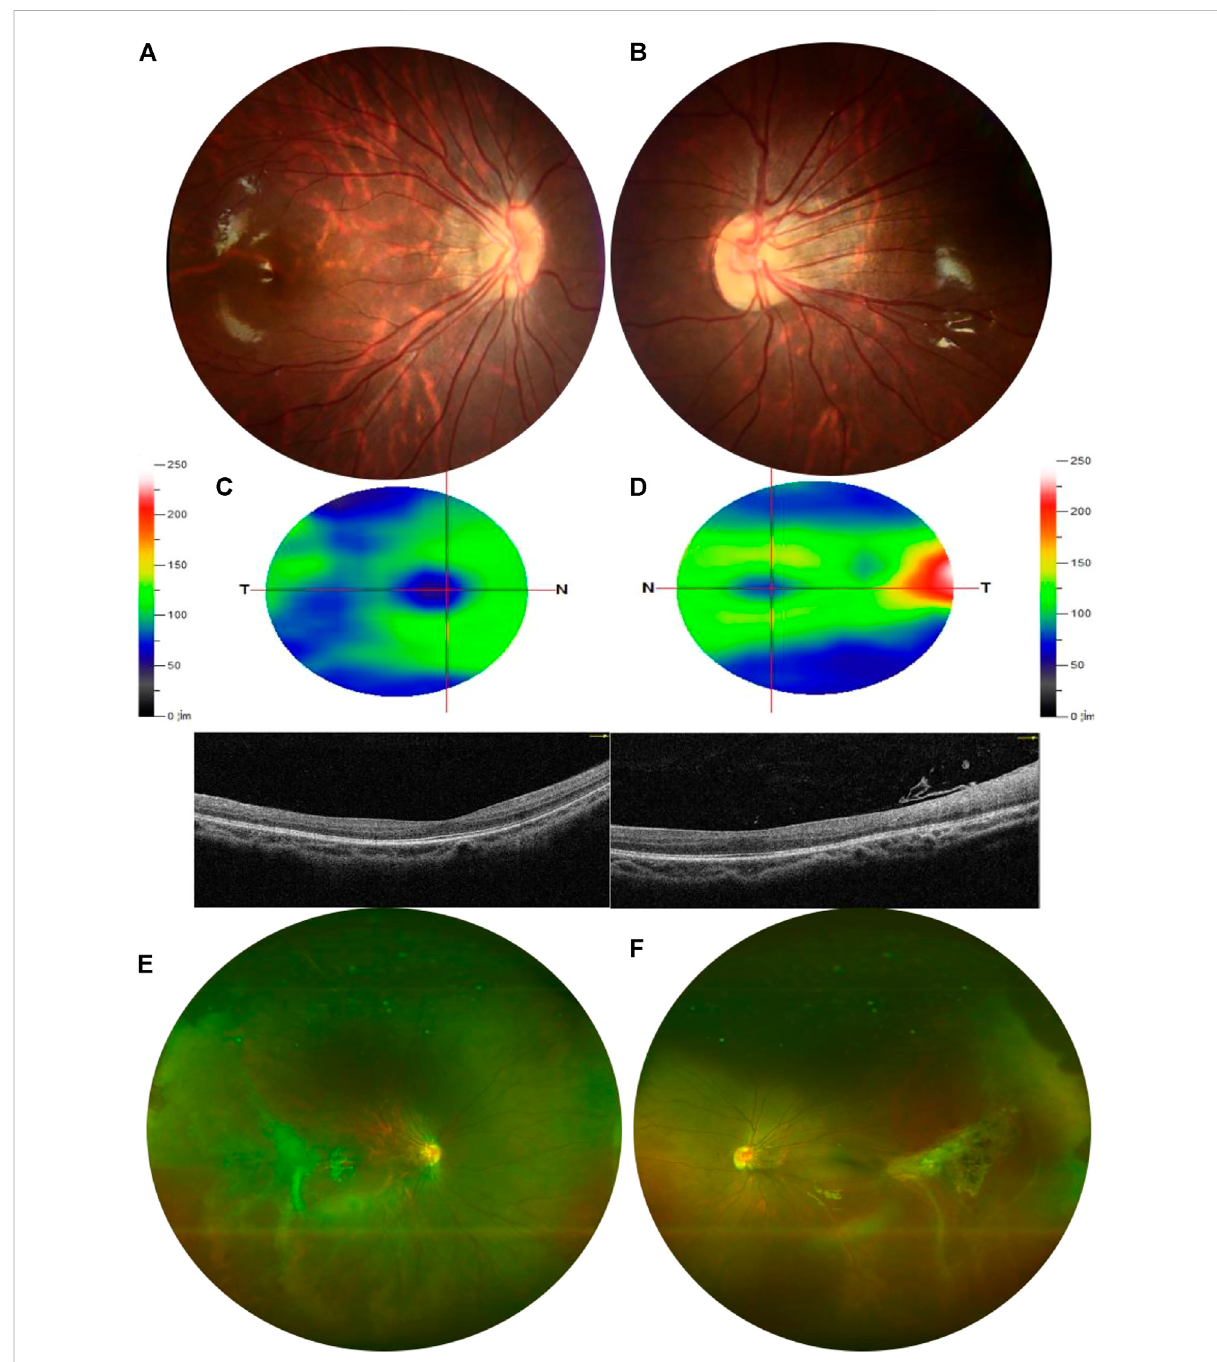
FIGURE 1 Examinationresultsoftheproband. (A,B) Coloroftheopticdiscwasslightlypaleinbotheyes,andtheretinalbloodvesselswerestretchedtothe temporal side, which was obvious in the left. (C,D) OCT showed that the inner and outer layers of the central fovea in the right eye were normal but diminished foveal contour with persistent inner foveal retinal layers in both eyes and no foveal depression on the left. The thickness of the superior retinal nerve fi ber layer (RNFL), inferior RNFL, and average RNFL was within the normal range. The thickness of the superior ganglion cell complex (GCC), inferior GCC, and average GCC was within the normal range. (E,F) Peripheral retinal blood vessels were fl at and numerous with avascular areas in both eyes. The peripheral retina of the left eye was accompanied by mild stretch proliferation and pigmentation